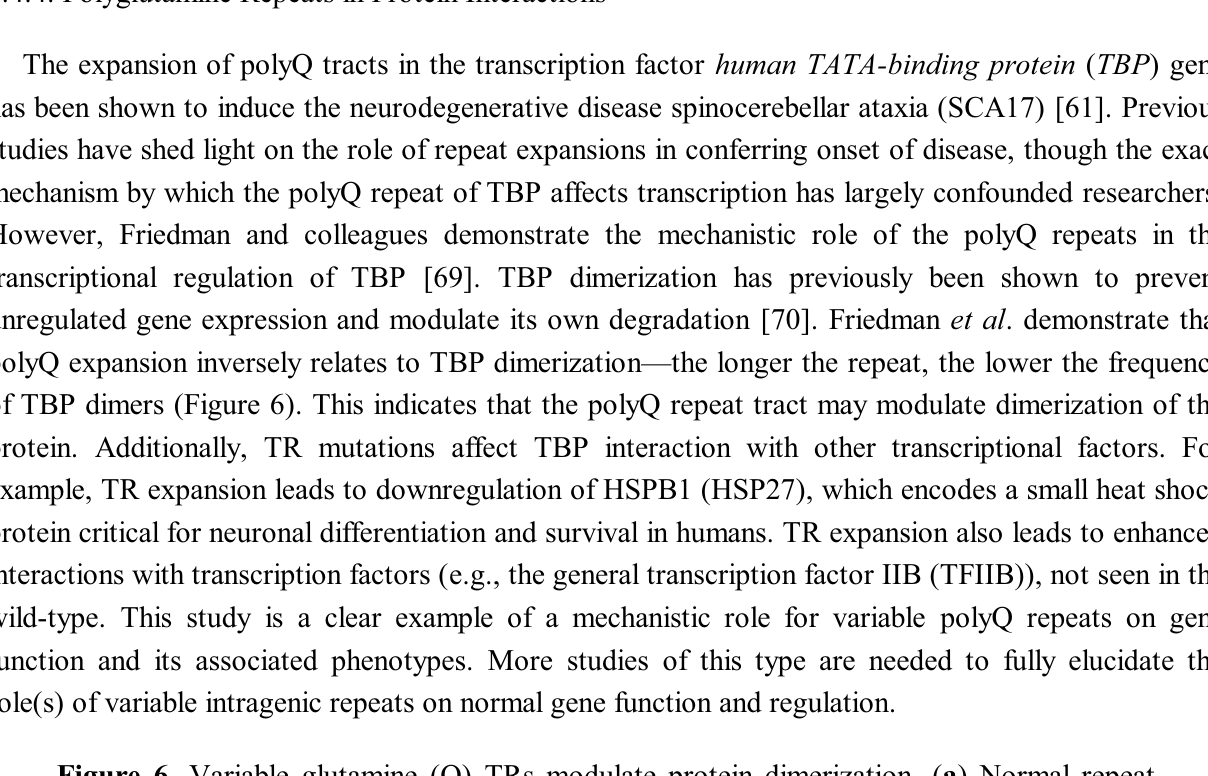
Figure 6. Variable glutamine (Q) TRs modulate protein dimerization. ( a ) Normal repeat length (ex . 13Q) of protein-interacting regions of the transcription factor TATA-binding protein allow for proper dimerization, initiating normal gene expression. ( b ) Expansion of polyQ repeats (ex. 71Q) inhibits dimerization causing irregular gene expression